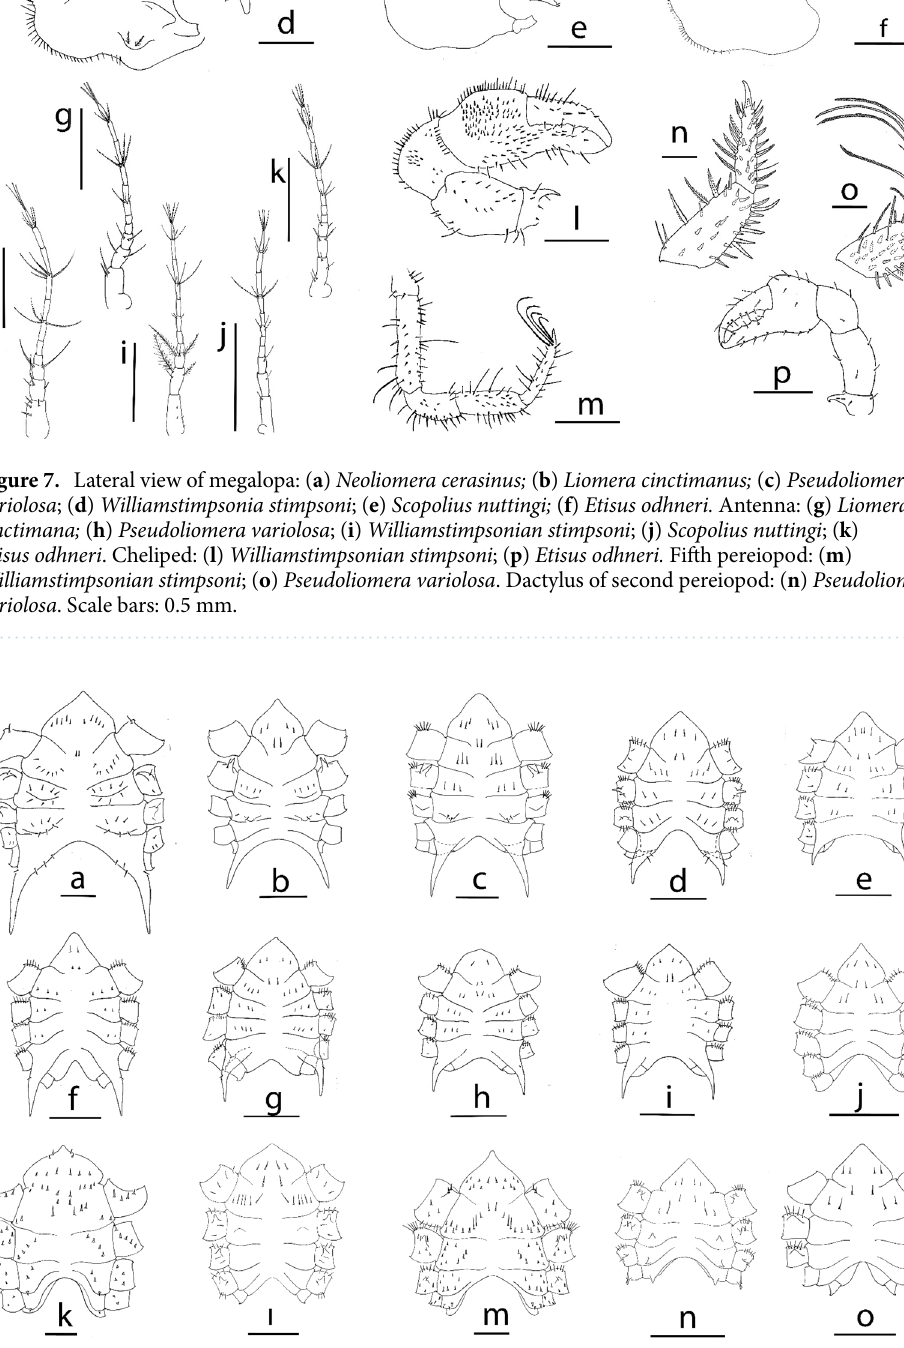
Figure 8. Sternum of megalopa: ( a ) Achelous floridanus ; ( b ) Arenaeus mexicanus ; ( c ) Portunus hastatus ; ( d ) Charybdis (Charybdis) hellerii ; ( e ) Thalamita admete ; ( f ) Callinectes toxotes ; ( g ) Callinectes arcuatus; ( h ) Callinectes ornatus; ( i ) Callinectes amnicola ; ( j ) Neoliomera cerasinus; ( k ) Liomera cinctimana; ( l ) Pseudoliomera variolosa ; ( m ) Williamstimpsonian stimpsoni ; ( n ) Scopolius nuttingi ; ( o ) Etisus odhneri . Scale bars: 0.5